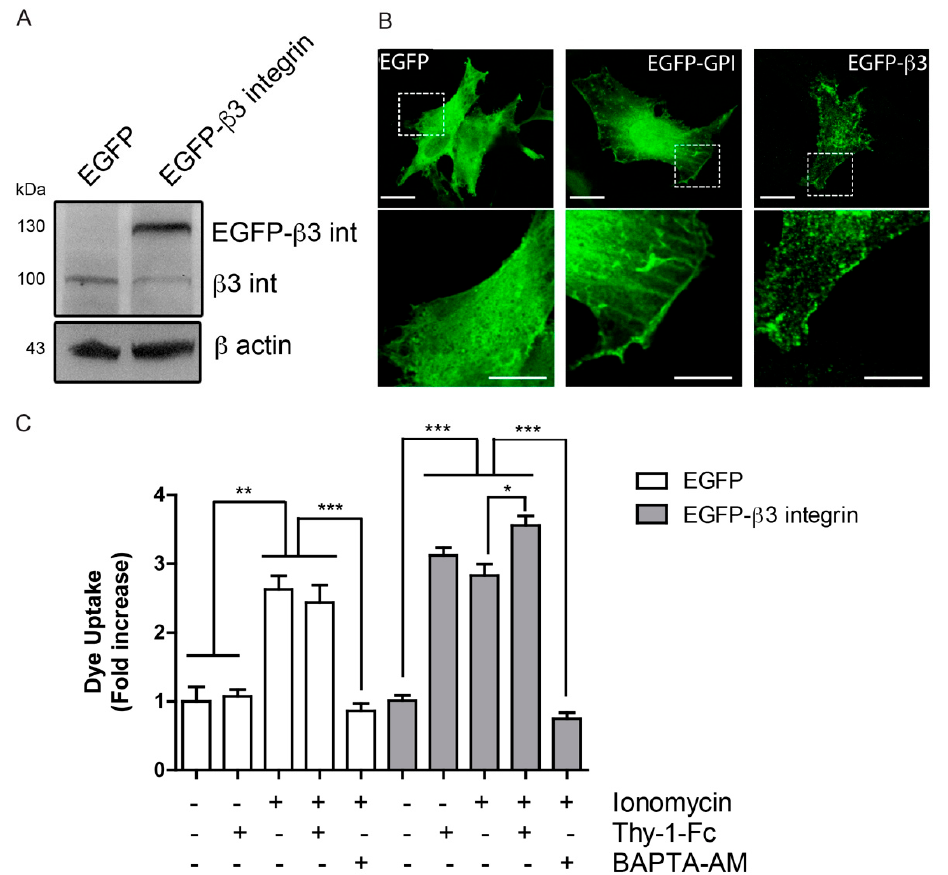
Figure 3. β 3 integrin overexpression forms integrin clusters at the cell surface. ( A ) Cell lysates of primary astrocytes transfected with pEGFP or pEGFP- β 3 integrin were immunoblotted for β 3 integrin and β -actin as a loading control; ( B ) Confocal images of primary astrocytes transfected with pEGFP, pEGFP-GPI or pEGFP- β 3 integrin were acquired 24 h after plasmid transfection. Scale bar = 20 µm. Outlined area defines the optically zoomed region shown below each photograph (bar = 10 µm); ( C ) Dye uptake by primary astrocytes transfected as in A, stimulated with Thy-1-Fc or ionomicyn (1 µM) for 10 min, or treated with the intracellular calcium chelator BAPTA-AM (5 µM) for 30 min prior to stimuli. Values in the graph are the mean fluorescence intensity normalized to the non-stimulated condition. Results show mean ± s.e.m. from three independent experiments, * p < 0.05, ** p < 0.01, *** p < 0.001.